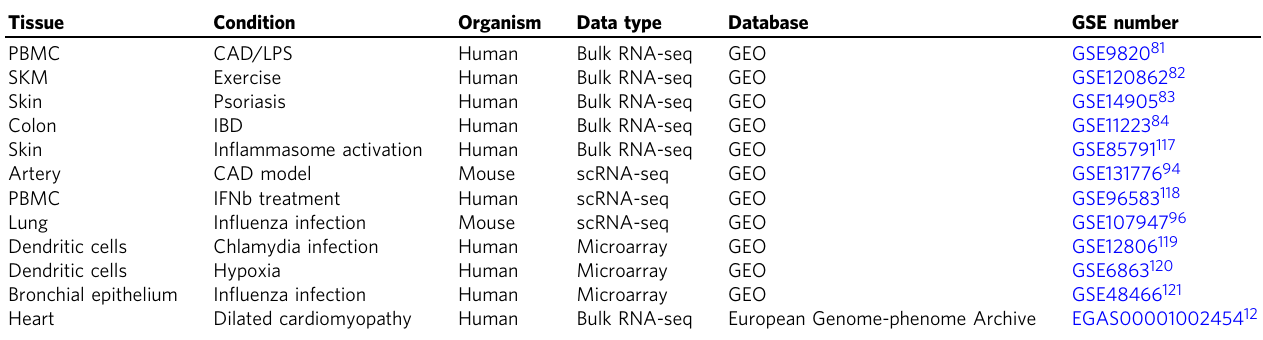
Table 1 List of published datasets that were